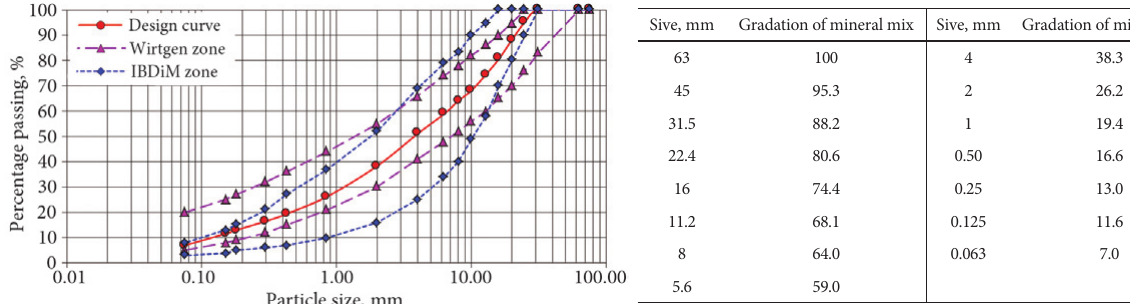
Fig. 2. Gradation of the mineral mix for recycled road base with foamed bitumen and with bitumen